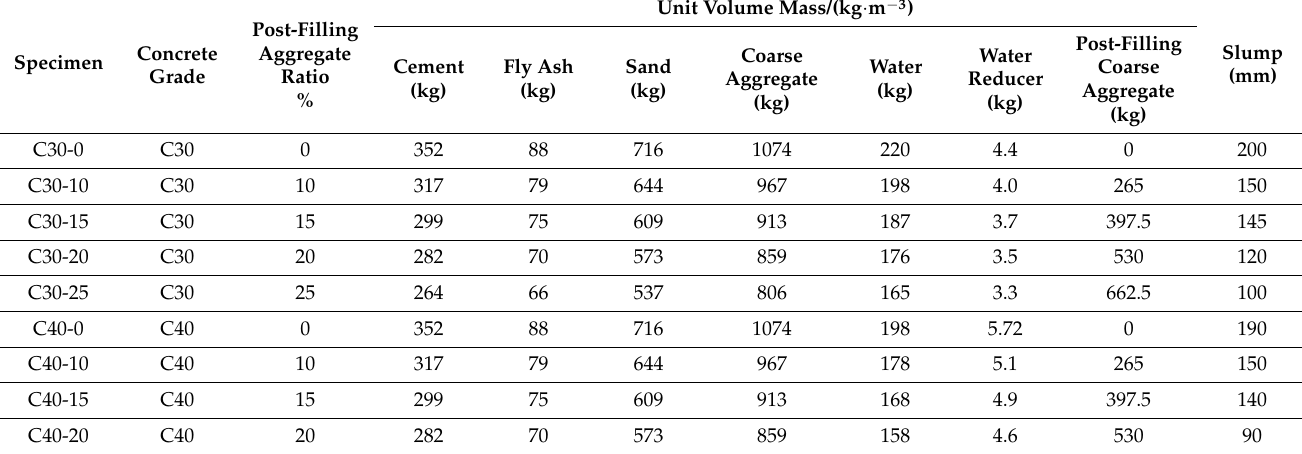
Table 1. Concrete mixture proportions and